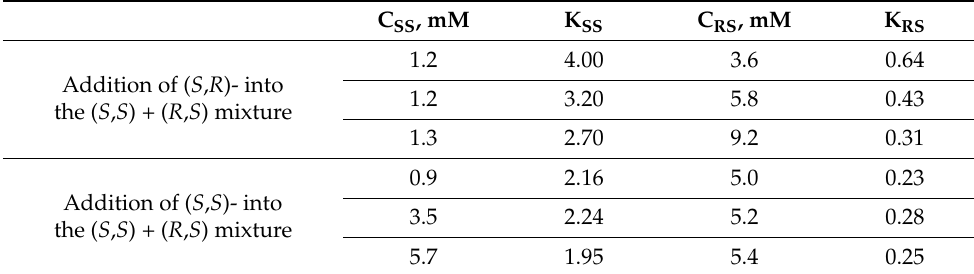
Table 5. SS dependence on the concentration of ( R , S )- and ( S , S )-diastereomers of dyad II [20]. C SS , mM K SS C RS , mM K RS Addition of ( S , R )- into the ( S , S ) + ( R , S )